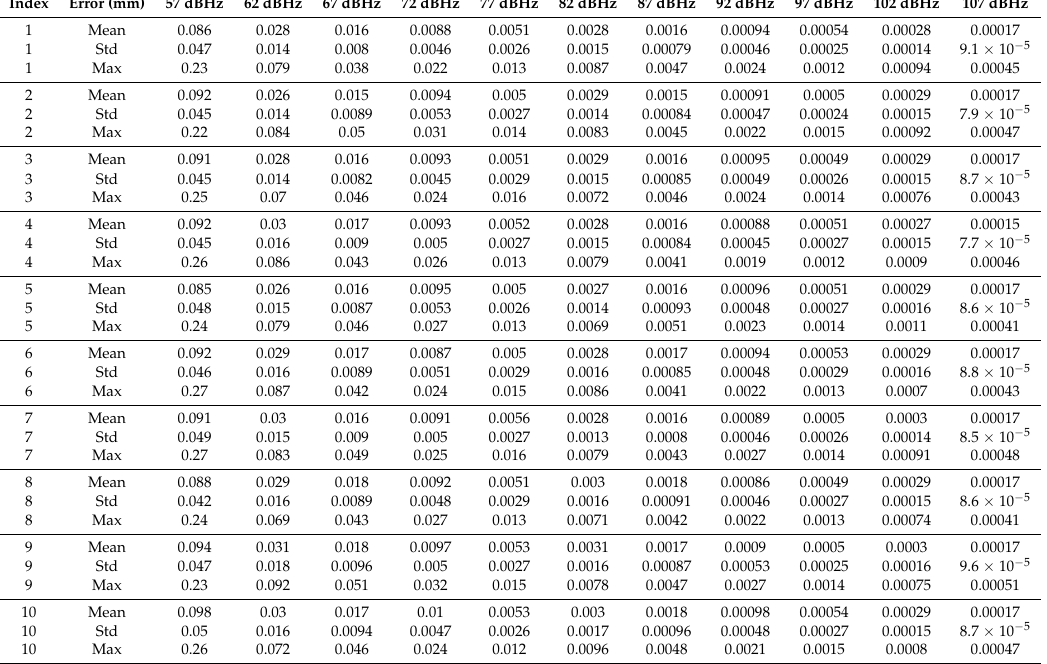
Table A3. Mean values, standard deviation, and maximum error values in the calculation of the impact point using CDMA-BPSK with a 10-bit size.